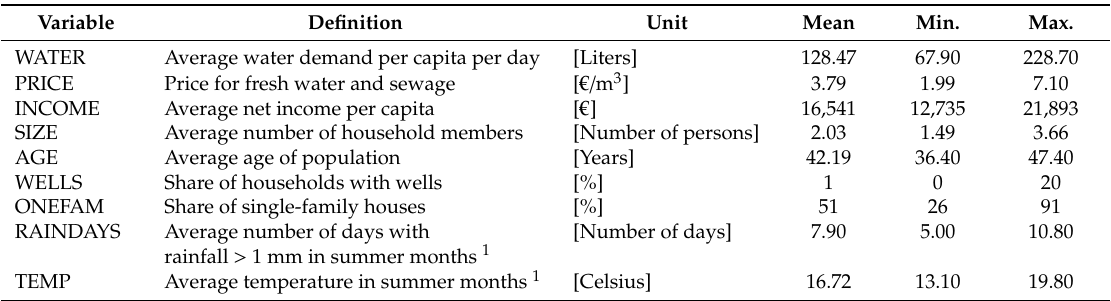
Table 1. Parameters impacting water demand and mean, minimum and maximum values for Germany on county level. Source: [5].